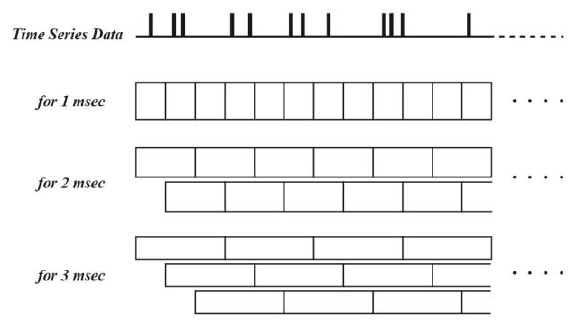
Figure 2. Schematic view of the Moving Bunching